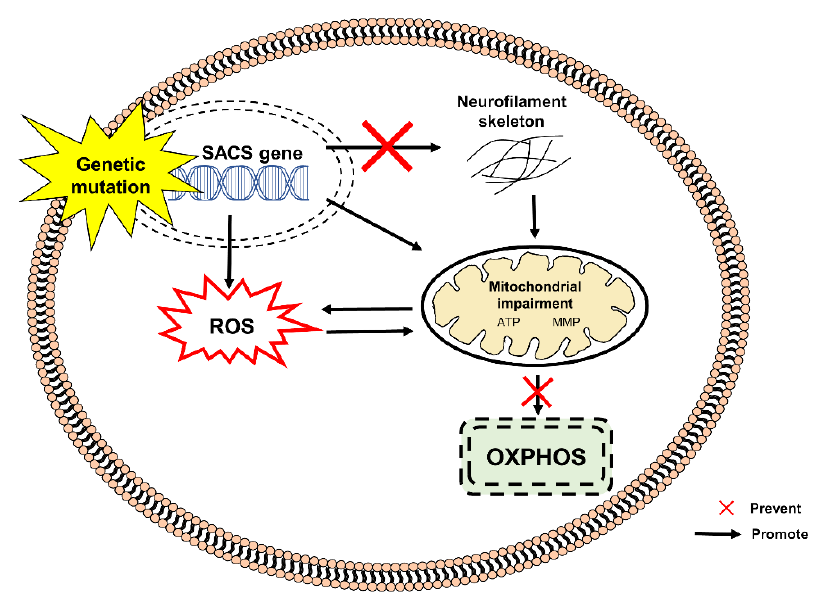
Figure 4. Mutation in the SACS gene in the pathogenesis of ARSACS. An absence or deficiency of SACS protein contributes to the excessive production of ROS, modification of neurofilaments and mitochondrial impairment. These events lead to further generation of ROS and disruption of OXPHOS. ATP, adenosine triphosphate; MMP, mitochondrial membrane potential; SACS, sacsin; OXPHOS, oxidative phosphorylation; ROS, reactive oxygen species.